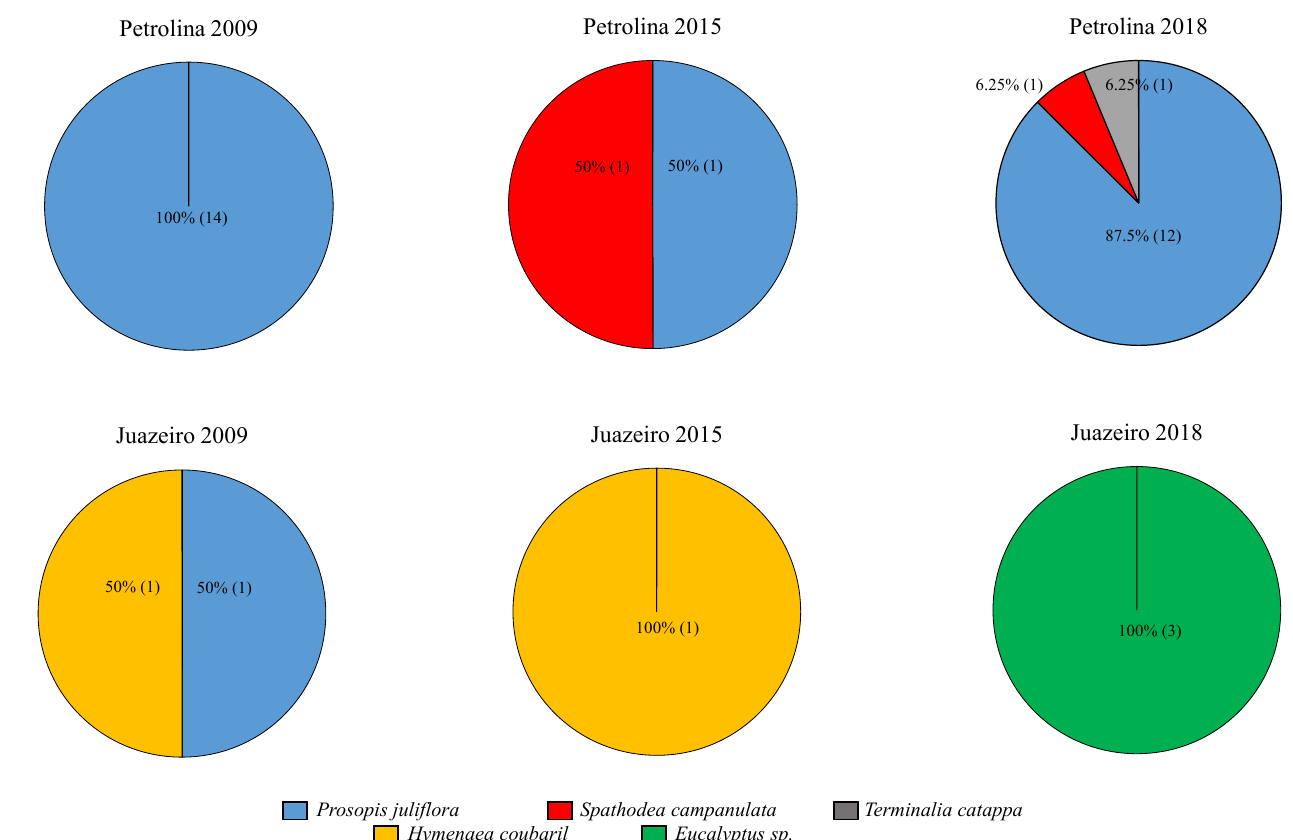
Fig 2 . Percentage (%) of nests of Plebeia aff. flavocincta in trees investigated in Petrolina and Juazeiro, in 2009, 2015 and 2018. (Numbers between parentheses are